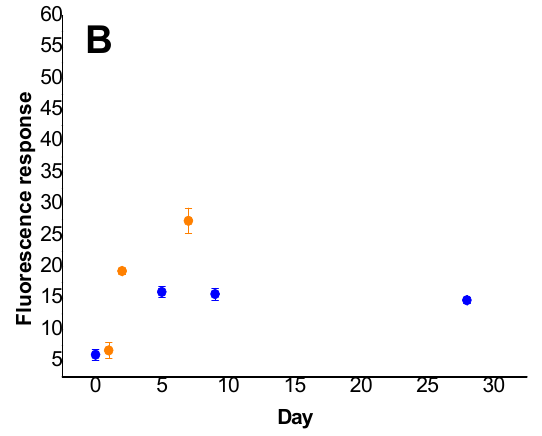
Figure 8. Fluorescence-based stability testing of ITP ( A ) and ICP ( B ) anchored to Rink Amide PEGA resin stored at room temperature (yellow dots) and at − 80 °C (blue dots) for defined number of days. Immobilized probes (2.0–2.1 mg) were dispersed in Tris-HCl buffer (0.1 M; 1 mL) and incubated for 15 min at 37 °C. Fluorescence emission was measured at 480 nm ( ITP ) and 595 nm ( ICP ) after excitation at 410 nm. Detector voltage was set to 600 V.